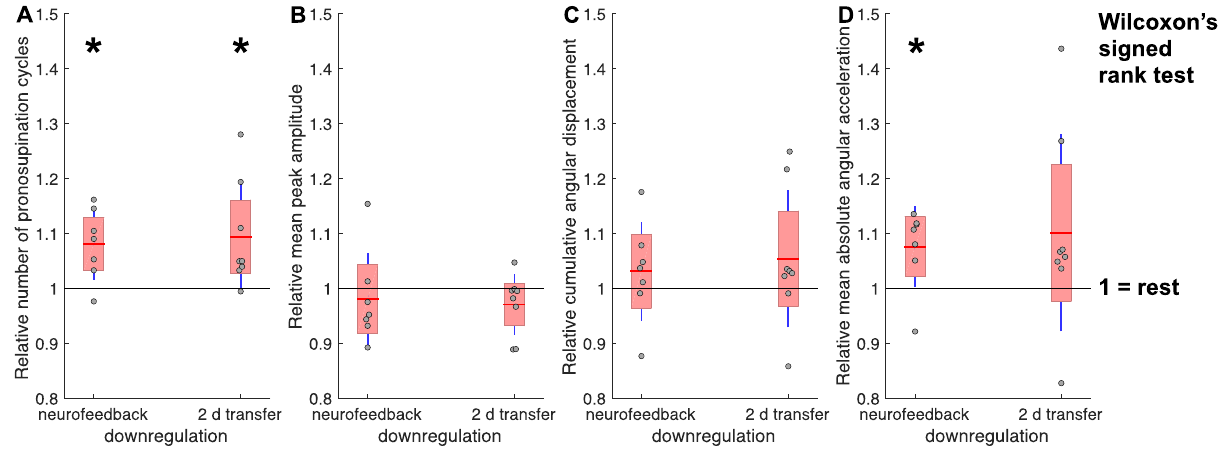
Figure 5. Behavioural output metrics during the first 12 s of pronosupination after downregulation during NF3 and short-term (2 days) mental strategy transfer. (A) The pronosupination frequency (proportional to the number of cycles during the first 12 s of pronosupination) was significantly increased after downregulation as compared to rest ( p = 0.0312 and p = 0.0156 during NF3 and 2 d mental strategy transfer, respectively) while (B) the mean peak angular amplitude was only slightly and non-significantly decreased. (C) The cumulative angular displacement (i. e. degrees travelled) was generally higher after downregulation as compared to rest. The grey rectangle highlights the mutual dependence between the three variables in (A–C) , i. e. frequency * mean peak angular amplitude = cumulative angular displacement. (D) The torque generated by the antagonistically acting pro- and supinator muscles was estimated through the mean absolute angular acceleration, which was significantly increased after downregulation as compared to rest during the neurofeedback experiment ( p =